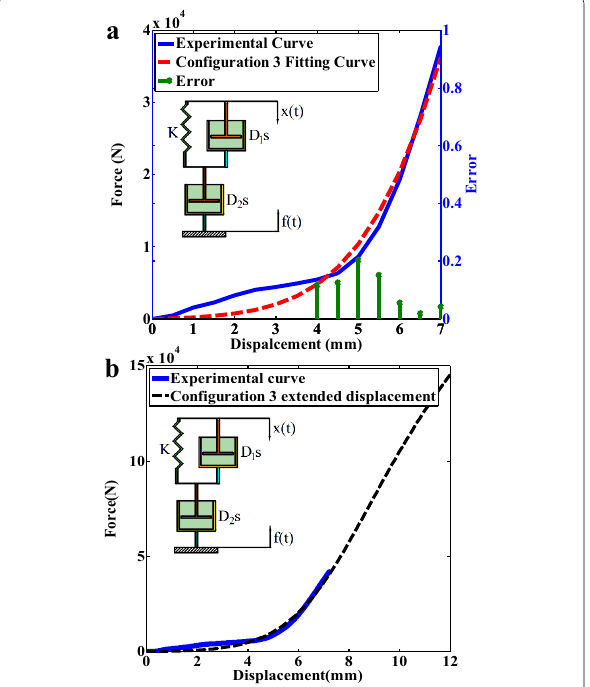
Figure 5 Configuration 3 equivalent mechanical model and verification results: a Results between experimental data and Eq. (15), b Verification of extended displacement of Eq. (15)